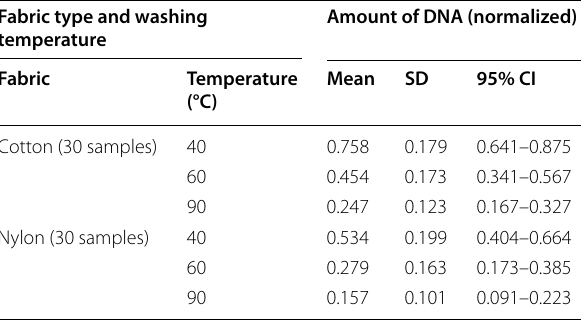
In order to categorically compare extracted DNA amount, each value is normalized by the highest extracted amount